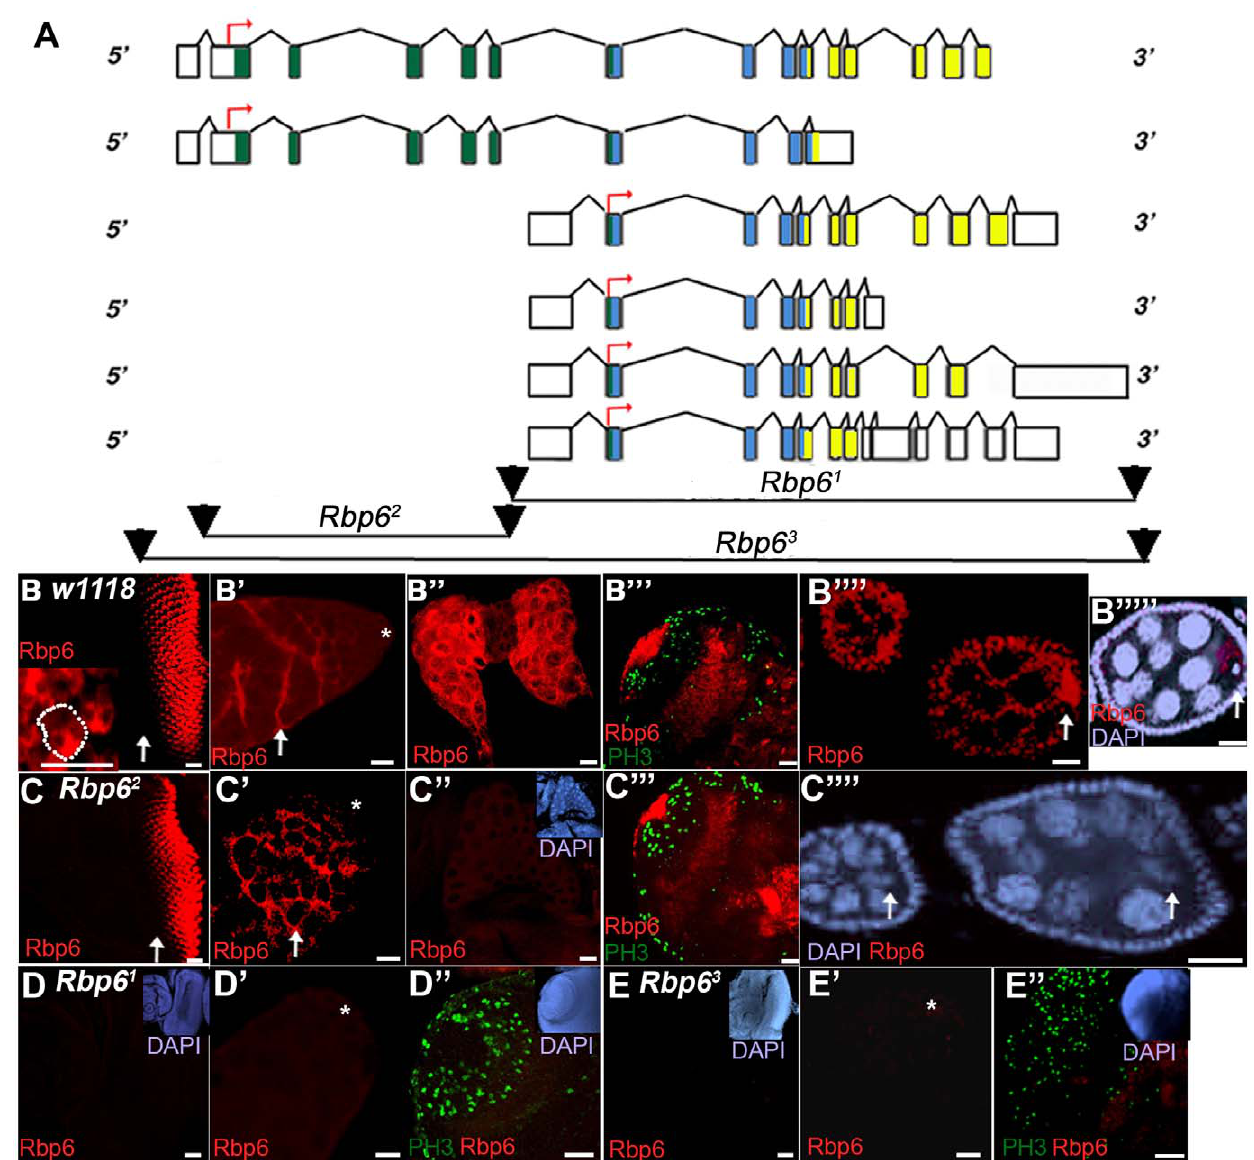
Figure 4. Expression of Rbp6 protein throughout development in w 1118 and Rbp6 mutant tissue. (A) Schematic of Rbp6 transcripts. The peptide synthesized for the generation of the Rbp6 antibody was derived from the exonic sequences depicted in yellow, thus the possibility remains that splice isoforms A, C, D, E and F could be detected with this antibody. The deletions generated in our study span different regions of Rbp6 (depicted at the bottom of A). (B) Rbp6 expression (red) in tissue dissected from w 1118 flies shows that Rbp6 is expressed posterior to the morphogenetic furrow (arrow) in third instar larval eye discs (B), in the cytoplasm of somatic cyst cells (arrow) in the adult testis (B’; hub is denoted by *), in the cytoplasm of cells in the third instar ring gland (B’’), in the non-proliferative cells of the third instar brain lobe (B’’’; dividing cells are labelled with Phosphohistone H3 (green)), and in the oocyte and nurse cells of the adult ovary (arrow; B’’’’–B’’’’’). In Rbp6 2 mutant tissue, no antibody expression was detected in the third instar ring gland (C’’) or the oocyte of the ovary (arrow; C’’’’), but was detectable in the eye disc (C), adult testis (C’) and larval brain lobe (C’’’). Rbp6 antibody expression (red) was undetectable in both Rbp6 1 (D–D’’) and Rbp6 3 (E–E’’) mutant tissue. Scale bars: 10 m m. mounting reagent, Prolong H Gold (Molecular Probes, Invitrogen). All secondary antibodies were Alexa Fluor antibodies obtained from Molecular Probes. Serial confocal sections were imaged on a Zeiss LSM510 Confocal Microscope. Phase microscopy imaging of meiotic spermatids from live testis preparations was carried out as previously described [10]. Acridine orange staining was performed on 0–3 day old adult testes (post eclosion) raised at 29 u C according to [36].